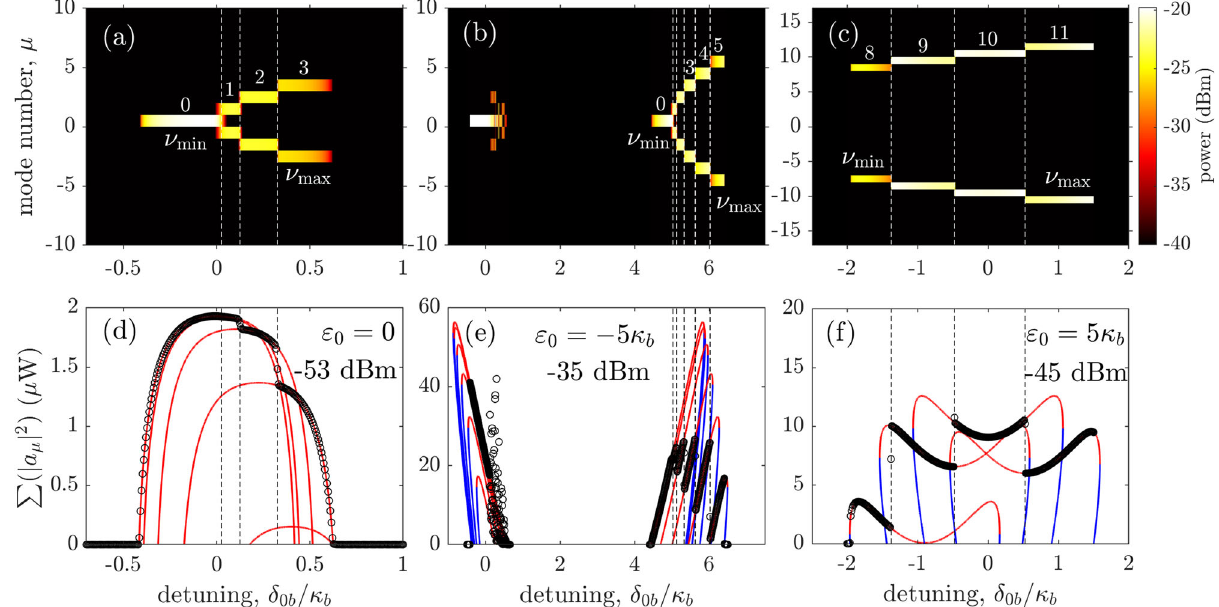
Fig. 3 Eckhaus instability ladders for small laser powers. Signal mode numbers ( a – c ), i.e., the ladder of Eckhaus instabilities, and power of the generated sidebands ( d – f ) vs detuning for the pump powers shown by the black dashed lines in the left column of Fig. 2: ( a , d ) W ¼ 5 nW ( − 53 dBm), ε 0 = 0; ( b , e ) W ¼ 316 nW ( − 35 dBm), ε = − 5 κ b ; ( c , f ) W ¼ 31 : 6 nW ( − 45 dBm), ε = 5 κ b . a – c Numerically simulated, Eq. (4), excitation of the signal sidebands ( fi eld 0 0 ' a ') vs pump detuning, δ 0 b . The numbers inside the panels indicate the respective sideband orders. The vertical dashed lines mark the instability boundaries of the states ν relative to the excitation of the ν + 1 sideband pair, i.e., λ ν , ν + 1 = 0 conditions, see Eqs. (22) and (23). The colour scale shows the sideband power. d – f Red and blue lines show the sideband powers vs δ 0 b as given by the analytical solutions in Eq. (17): j a þ ν j 2 þ j a þ j 2 (red) and j a (cid:1) ν j 2 þ j a (cid:1) j 2 (cid:1) ν (cid:1) ν (blue). Black circles show the numerically computed sideband powers corresponding to the data in the top row. The detuning range around δ 0 b ≈ 0.5 κ b in the middle column corresponds to the breather